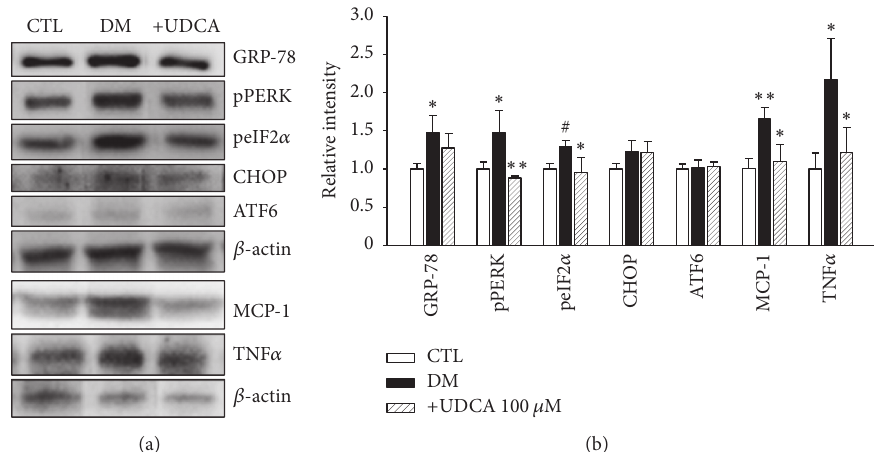
Figure 3: Induction of UPR and inflammatory cytokines and UDCA-mediated attenuation in diabetic mice. Levels of UPR markers and inflammatory cytokines were assessed via western blot analysis of eye tissue from control ( 𝑛 = 5 ), nontreated DM ( 𝑛 = 5 ), and UDCA-treated DM ( 𝑛 = 5 ) groups. (a) Representative results of western blot analyses are shown. (b) Increased levels of GRP78, pPERK, peIF2 𝛼 , MCP-1, and TNF 𝛼 in diabetic mice, compared to the control group, were attenuated by UDCA. ATF6 and CHOP expression was not significantly different among groups. CTL: control mice, DM: nontreated diabetic mice, and +UDCA: diabetic mice treated with UDCA, ∗ 𝑃 < 0.05, ∗∗ 𝑃 < 0.01, # 𝑃 < 0.005.